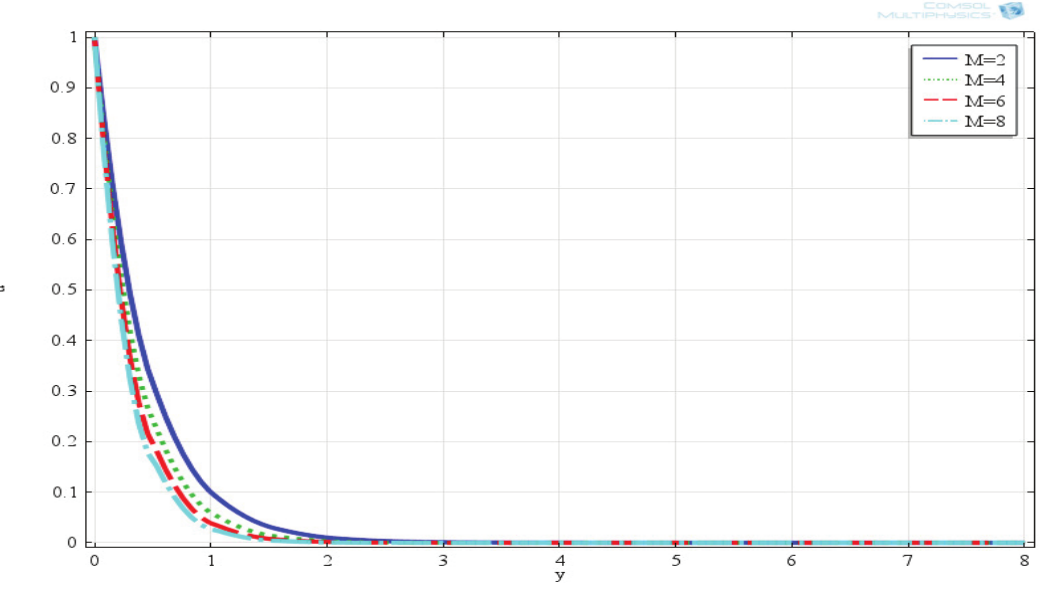
Figure 5: Steady state velocity profiles for different values of M